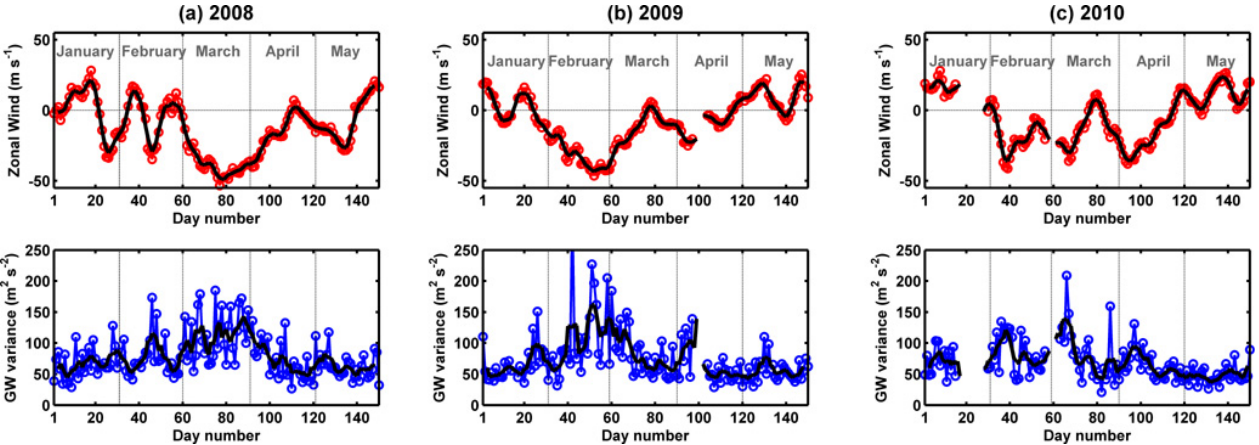
0 2 + 0 2 v ) /2) (bottom panels) in